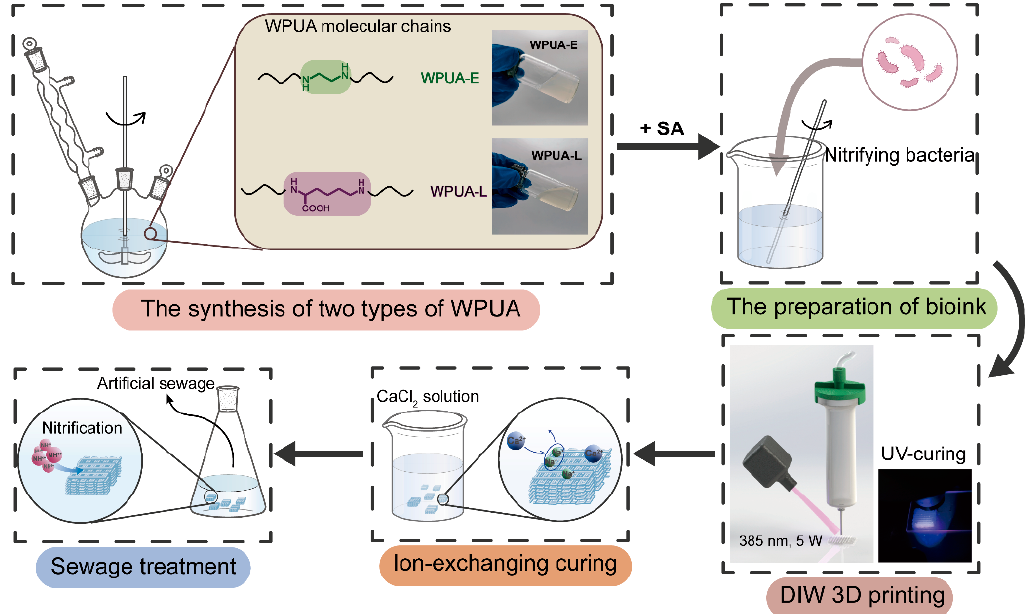
Figure 1. The synthesis, bioprinting and application of WPUA in sewage treatment.